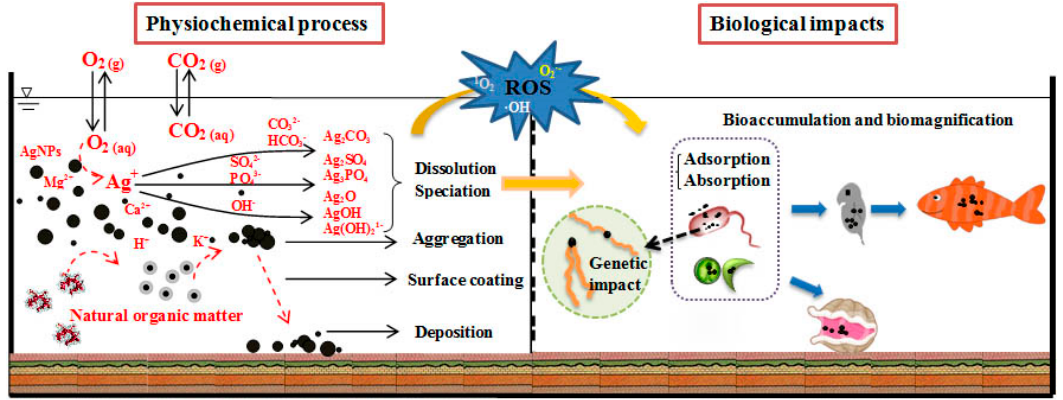
Figure 1. Potential physiochemical processes and biological impacts of metal-based NPs (e.g., Ag NPs) in natural waters (reprinted with major modification from [44] with permission, Copyright Elsevier, 2011).